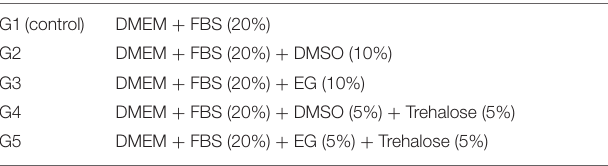
TABLE 2 | Composition of experimental cryoprotectant